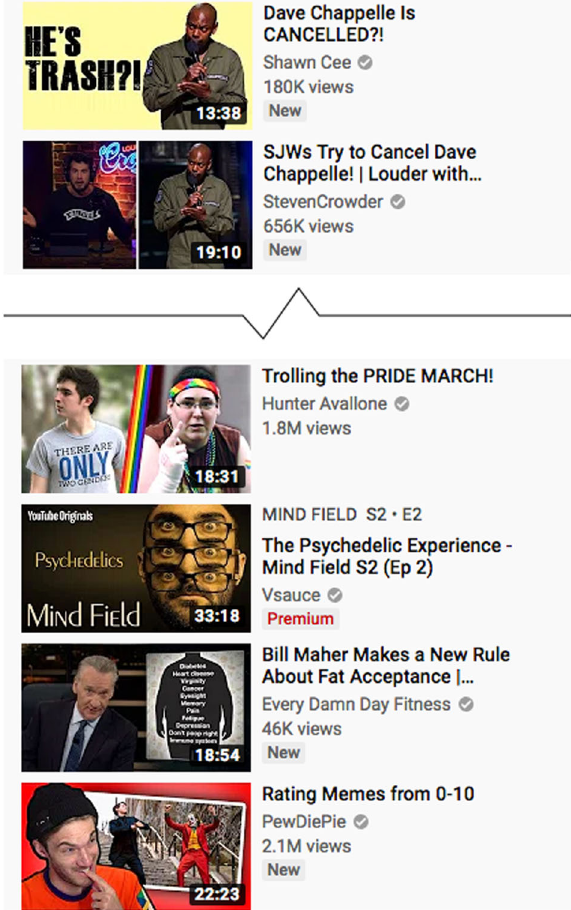
Fig. 5 YouTube Recommendations. Screenshots showing anti-SJW (social justice warrior) and anti-LGBTQ + recommendations in response to viewing a centrist-right video by popular talk show host Joe